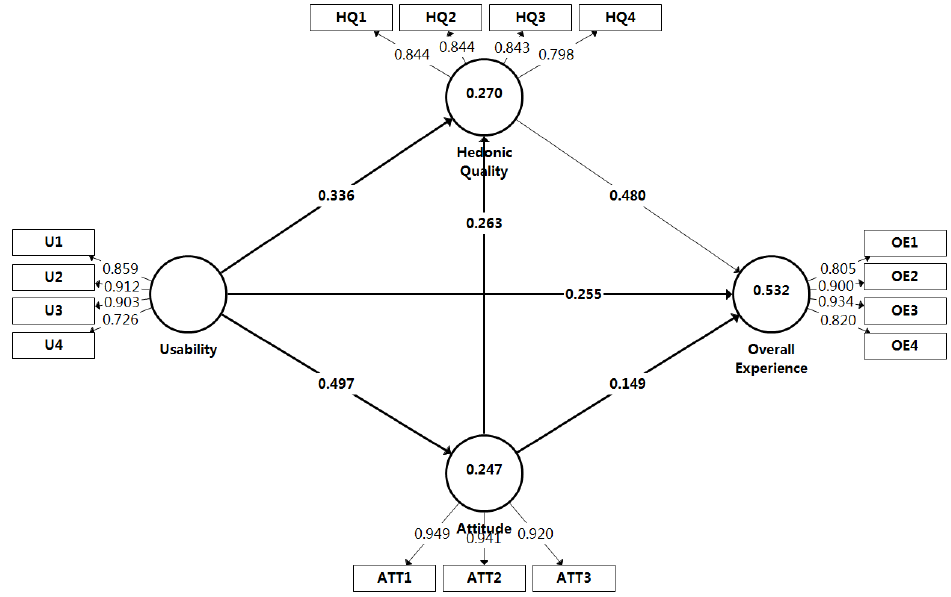
Figure 3. Path coefficients of the research model. Table 6. Values of f 2 .